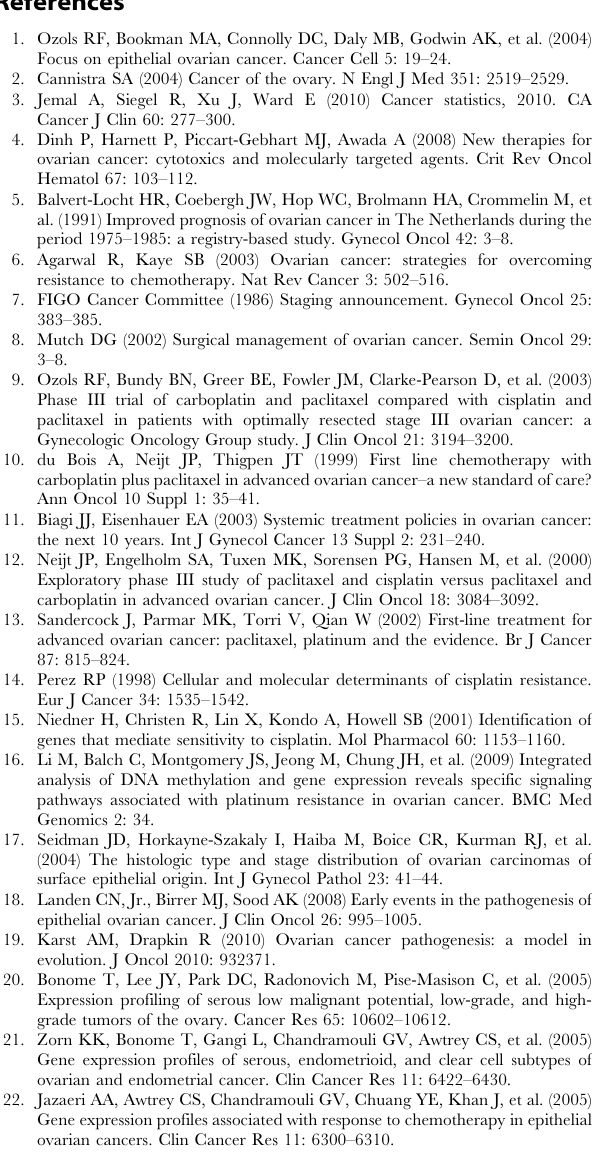
Figure S1 Supervised clustering of TCGA samples. (TIF) Figure S2 GISTIC analysis of TCGA clusters. (TIF) Figure S3 DNA copy number analysis of UCSF-GOG samples. A. Summary of CNAs in UCSF-GOG dataset. B–C. GISTIC analysis of UCSF-GOG dataset. (TIF) Figure S4 Supervised clustering of UCSF-GOG dataset. (TIF) Figure S5 Kaplan-Meier analysis of UCSF-GOG clusters. (TIF) Table S1 Probe set corresponding to amplification and deletion peaks used for supervised clustering.